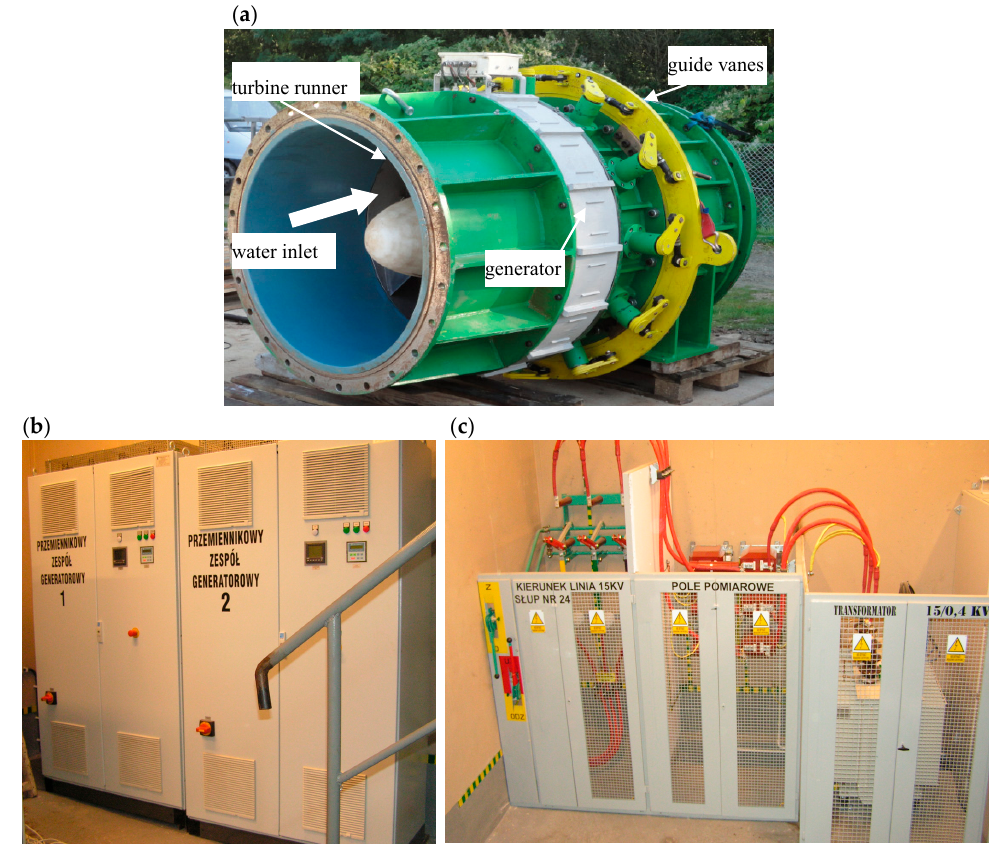
Figure 5. The experimental SHP: ( a ) hydro-set of 75 kW, ( b ) two power electronic converters (PECs) of 90 kW and ( c ) grid connection devices.